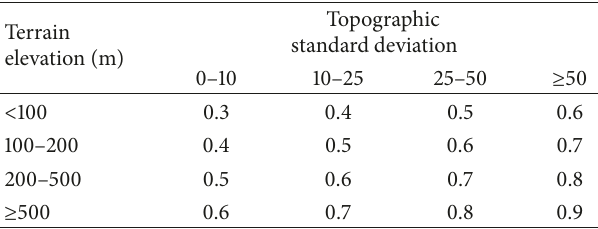
Table 2: Assignment table of terrain vulnerability.